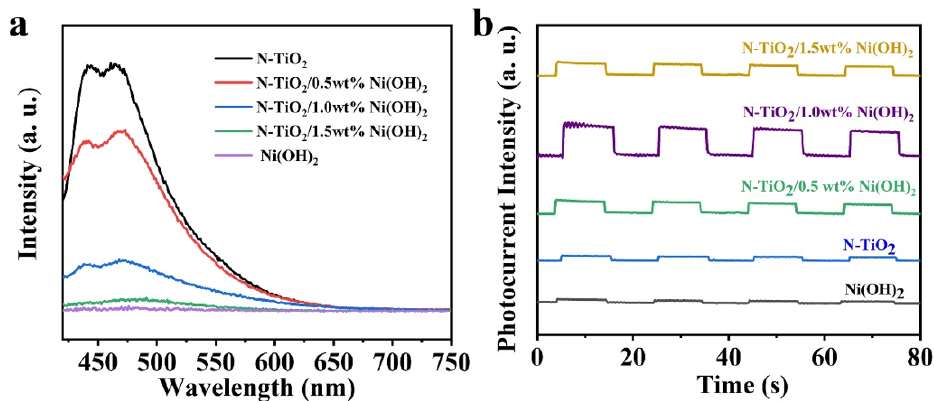
Figure 6. ( a ) PL spectra and ( b ) photocurrent response (>420 nm)of N-TiO 2 , Ni(OH) 2 , and N- TiO 2 /Ni(OH) 2 with di ff erent Ni(OH) 2 content, respectively.